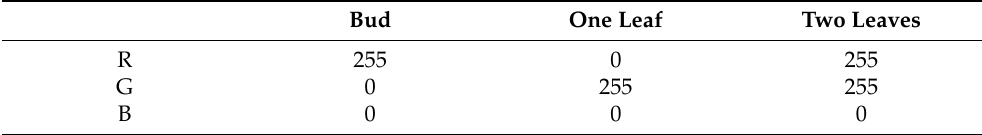
Figure 7. Picking point identification process. Table 4. Segmentation thresholds of tea